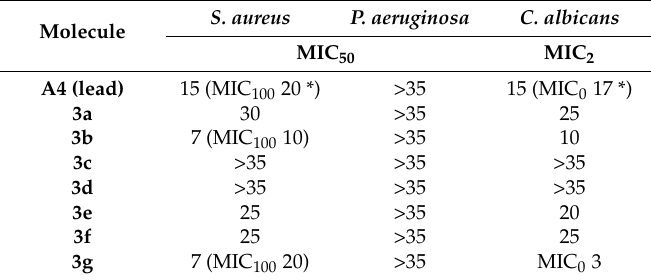
Table 2. Antimicrobial and antifungal activity of A4 analogues. Geometric mean MICs ( µ g/mL) after 24 h. S. Molecule